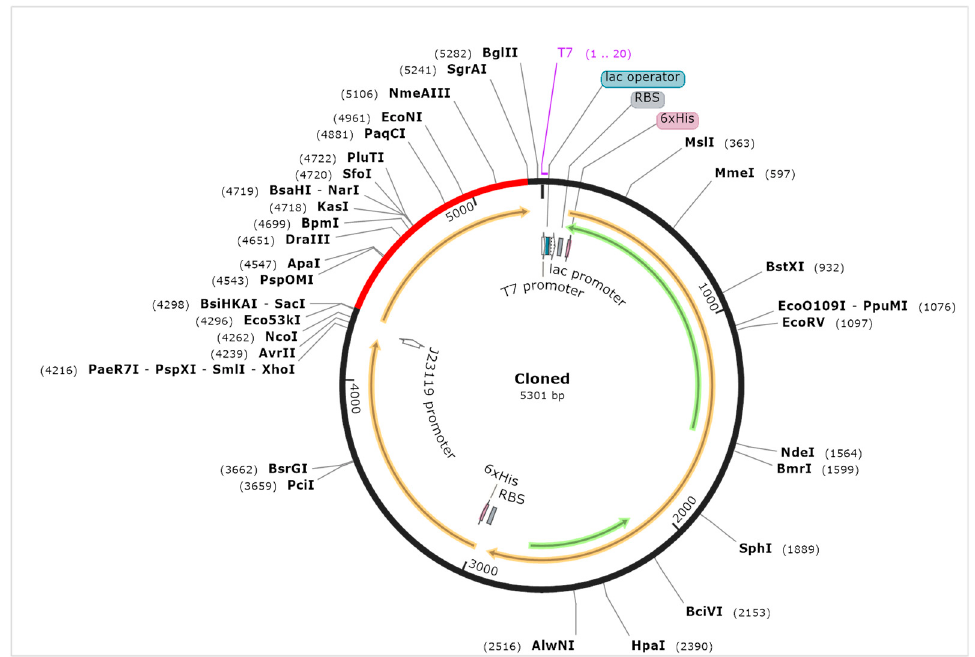
Figure 5. Codon optimization and computational cloning of vaccine construct using JCat and SnapGene tool.